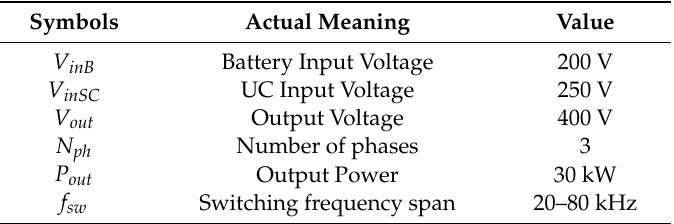
Table 5: Equation for loss estimation of DC-DC converters.